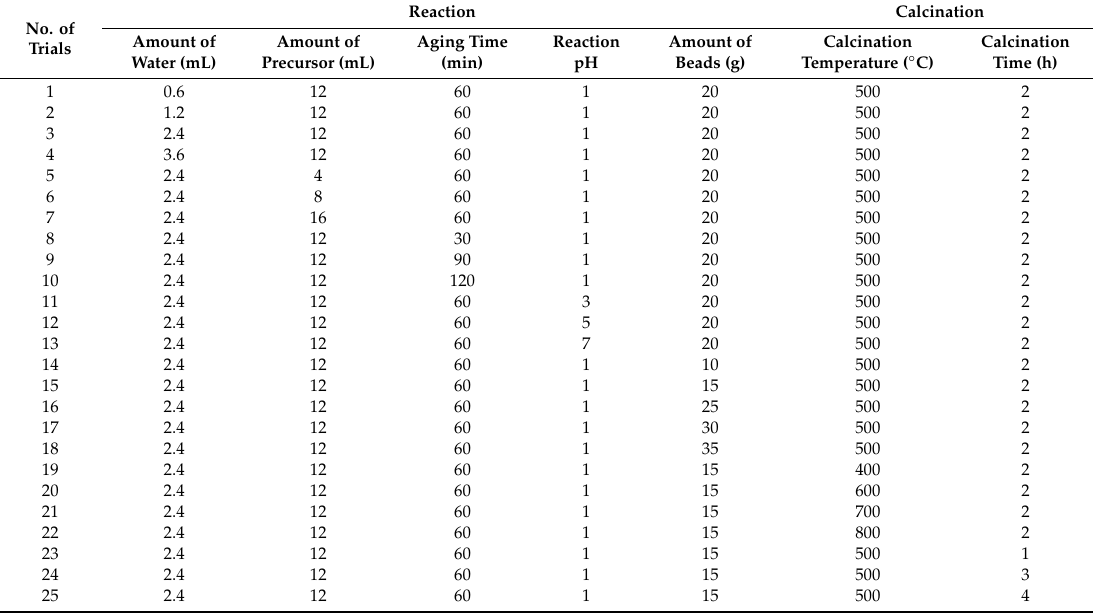
Table 1. Preparation conditions of photocatalyst by sol-gel